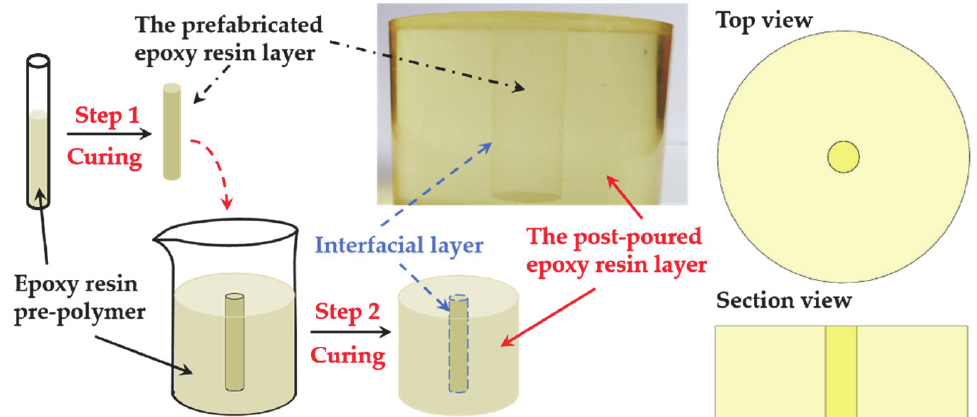
Figure 3. Schematic diagram of the preparation process of sample with an interfacial layer. For step 1, the epoxy resin pre-polymer was poured into a test tube, and the prefabricated epoxy resin layer (marked with a black dot-dashed line) was obtained after curing. For step 2, the prefabricated layer was placed into a mold, and the same pre-polymer in step 1 was poured into the beaker. Finally, after curing, the sample was obtained with an interfacial layer (marked with a blue dashed line) between the prefabricated layer and the post-pouring layer (marked with a red solid line).